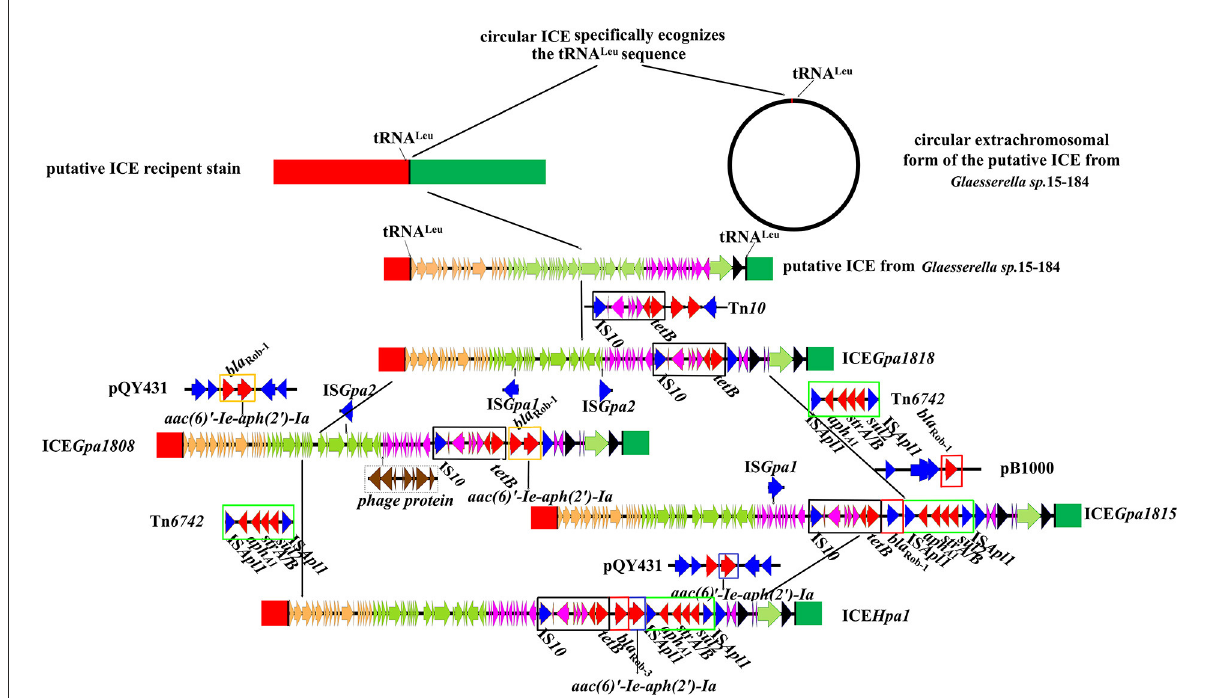
FIGURE5 Schematic representation of the stepwise evolution process of ICE Hpa1 . Genes are presented as broad arrows, with the arrowhead indicating the direction of transcription. The reference sequences include the putative ICE in Glaesserella sp. 15-184 (CP023057), ICE Gpa1818 (CP071487), ICE Gpa1808 (CP071490), ICE Gpa1815 (CP071489), ICE Hpa1 (CP054198), transposon Tn 10 (AF162223), transposon Tn 6742 (MN844034), plasmid pQY431 (KC405065), and plasmid pB1000